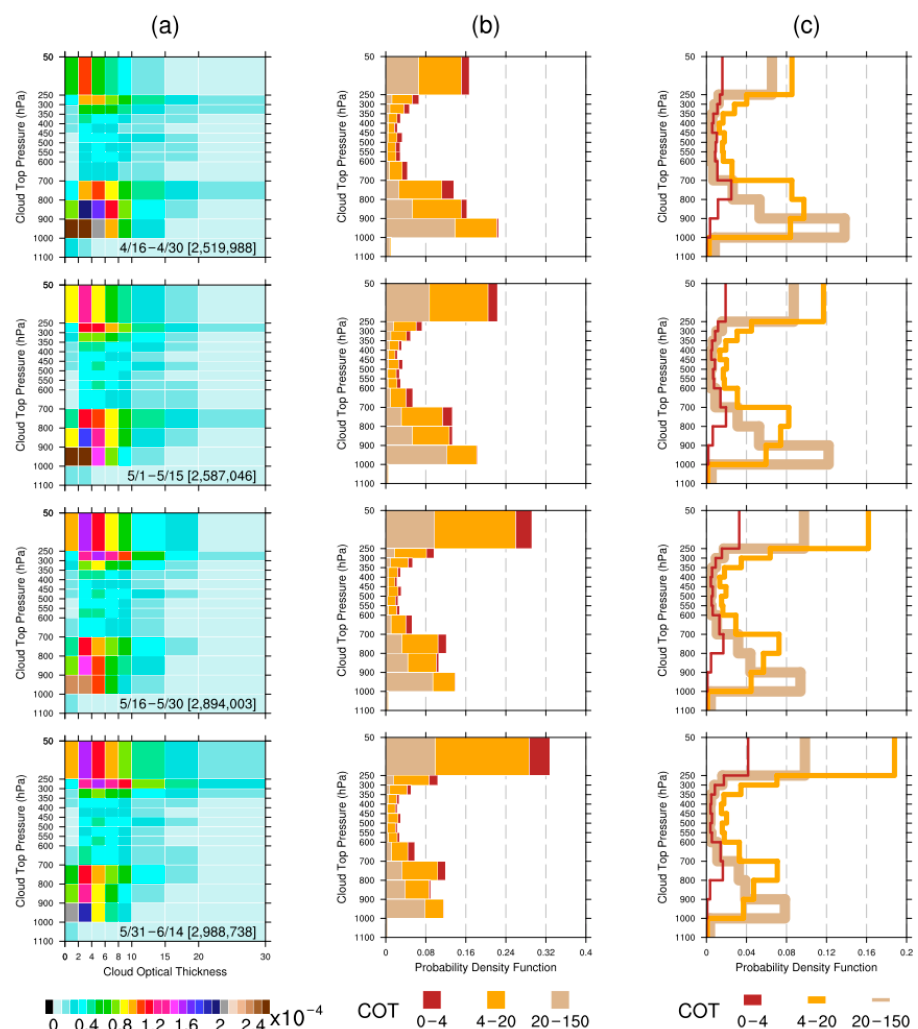
Figure 5. The seasonal variation of the joint probability distribution of the COT binned against CTP for liquid water clouds over the ICP. The seasonal variation is revealed by the statistics of four 15- day periods from 16 April to 14 June in the years from 2003 to 2021. From top to bottom panels, the 15-day periods are 16 April to 30 April, 1 May to 15 May, 15 May to 30 May, and 31 May to 14 June, respectively. ( a ) The normalized joint probability is displayed as two-dimensional histograms, with COT as the x -axis and CTP as the y -axis. The number in square brackets is the total count for each statistical period. For every bin box, the joint probability value is equal to the bin count divided by the total count (relative frequency). The normalized joint probability in each bin box is computed by dividing the corresponding joint probability value by the bin size (the area of that particular bin box), thereby obtaining the probability density value of the bin box. This normalization is intended to take into account the bin sizes so as to eliminate any visual distortions when comparing bins of different sizes in the two-dimensional histogram plot. The probability of any pixel that falls in a joint histogram bin box can be retrieved after multiplying the corresponding probability density value by that bin size. The bin colors represent the probability density values in each bin. The COT histogram bins ranging from 30 to 150 were chopped off for plotting purposes, owing to the large bin range and very low probability density. The marginal probabilities of CTP with respect to three COT categories are displayed as ( b ) stacked and ( c ) overlapping histograms, with probability as the x -axis and CTP as the y -axis. The marginal probabilities of CTP are derived from the joint histograms of COT binned against CTP. The COT is grouped into three categories of newly aggregated bins from the original COT histogram bins: 0–4, 4–20, 20–150. Three sets of the marginal probability of CTP are obtained by integrating (summing) the joint probability over the specific ranges of the ag- gregated bins from the three COT categories, respectively.